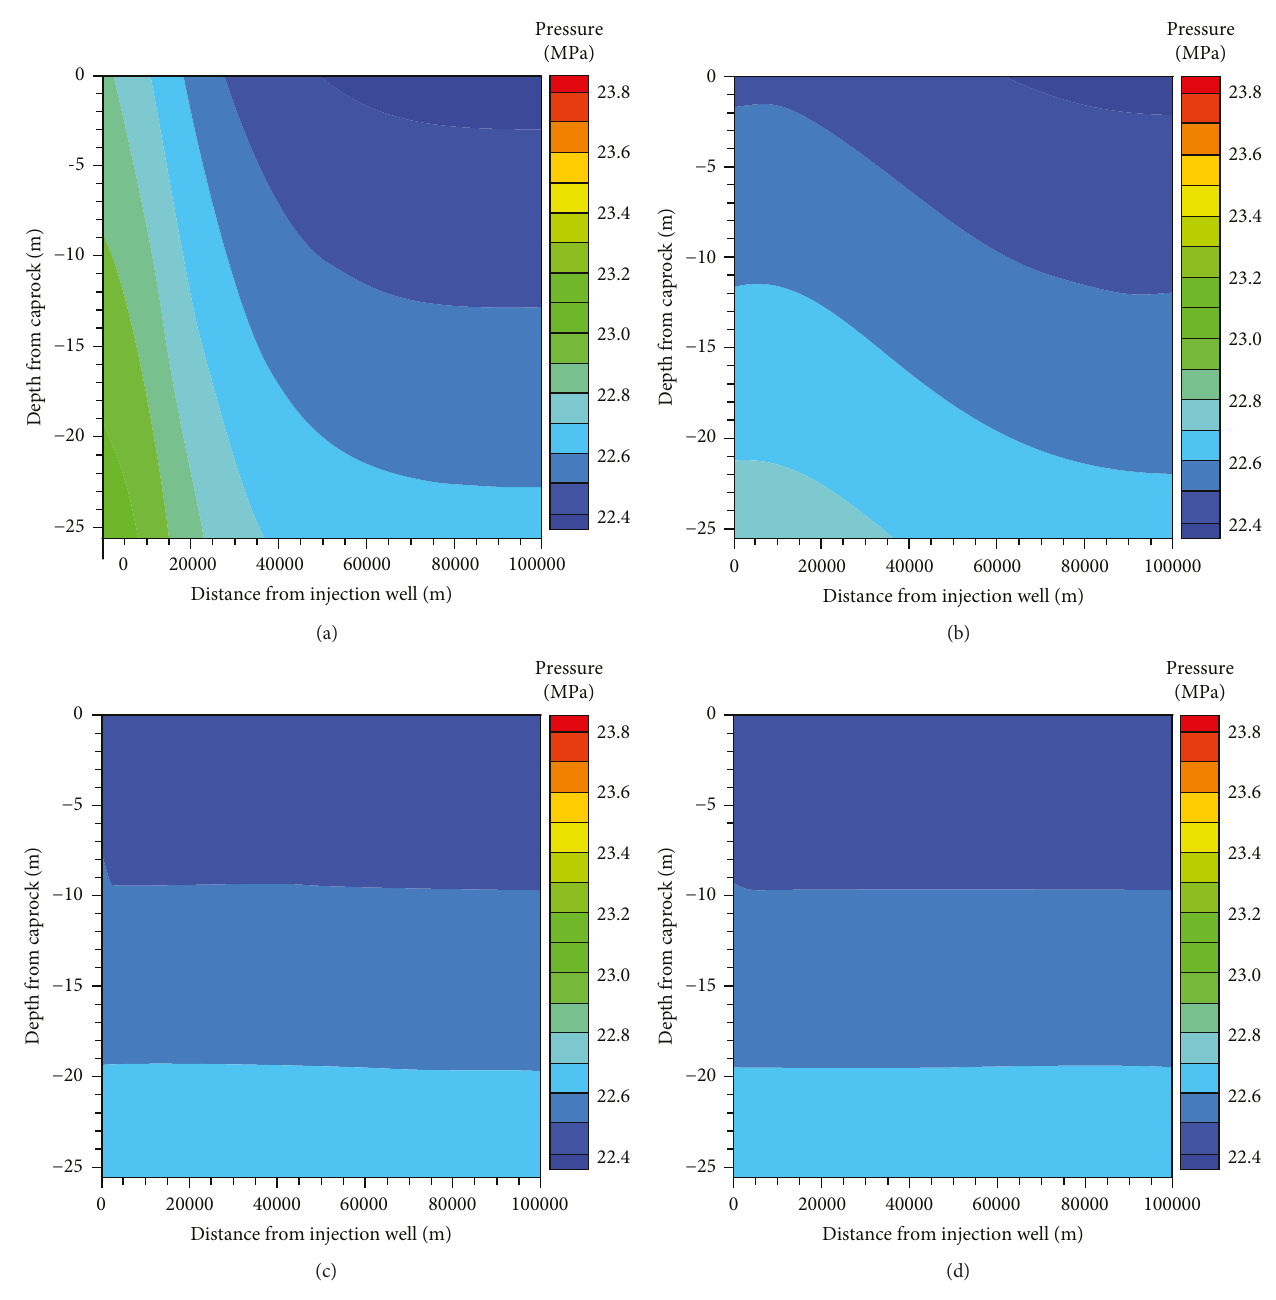
Figure 12: Evolution of the reservoir pressure fi eld after the cessation of CO